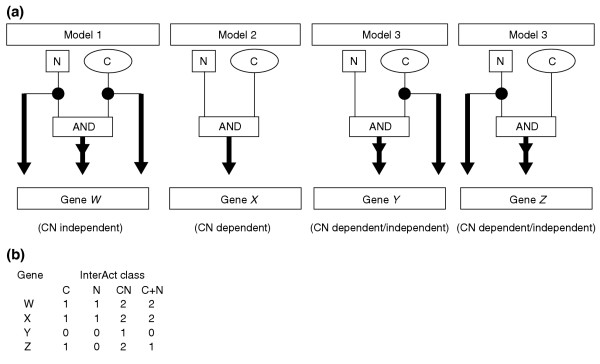
Transcriptional regulation by carbon and nitrogen interactions. (a) Interactions between carbon (C) and nitrogen (N) signaling can be explained by three models, and an example(s) of each is given. Model 1, carbon and nitrogen regulation are independent and therefore are additive. Model 2, carbon and nitrogen are dependent, as both are required for an effect. Model 3, there is a dependent and independent component to carbon and nitrogen regulation. Two examples of Model 3 are shown (genes Y and Z). For gene Y, nitrogen only has an effect in the presence of carbon, while for gene Z, carbon only has an effect in the presence of nitrogen. (b) The assignment of genes W, X, Y, and Z to InterAct classes.